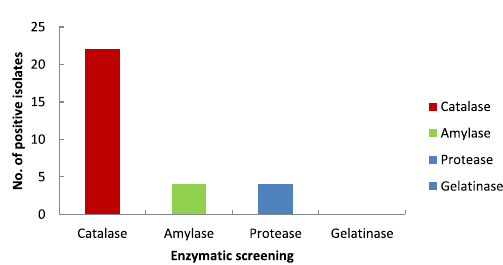
Fig. 2. Enzymatic activity test of Kanchengayao glacier